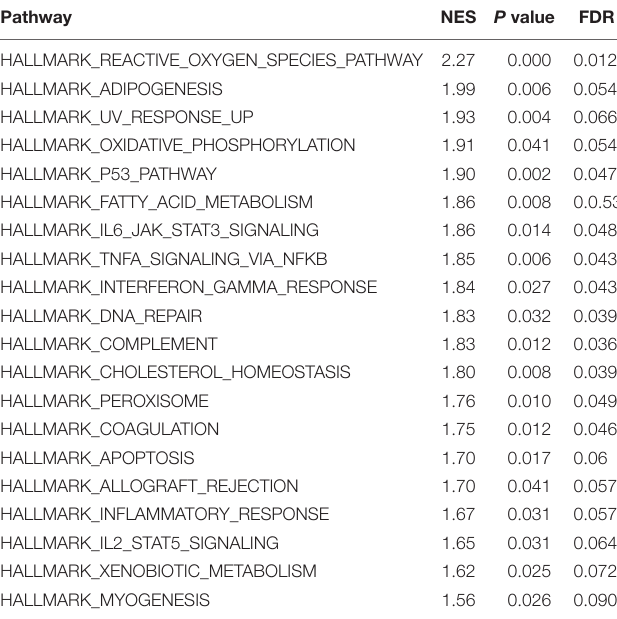
TABLE 4 | The results of Gene set enrichment